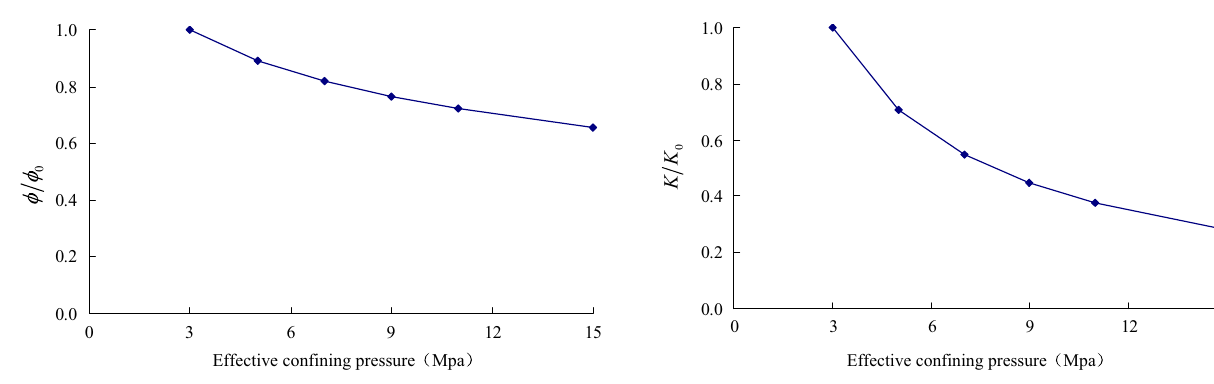
Fig. 6 Change laws of the porosity with effective confining pressure (the 1st cycle)